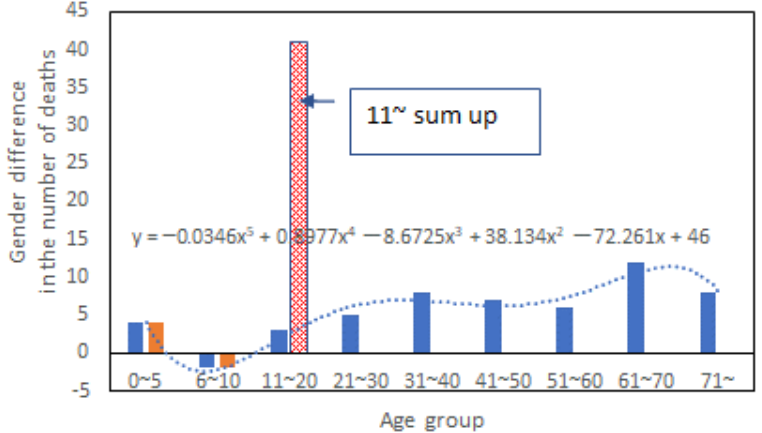
Figure 3. In-house death difference between men and women for different age groups.